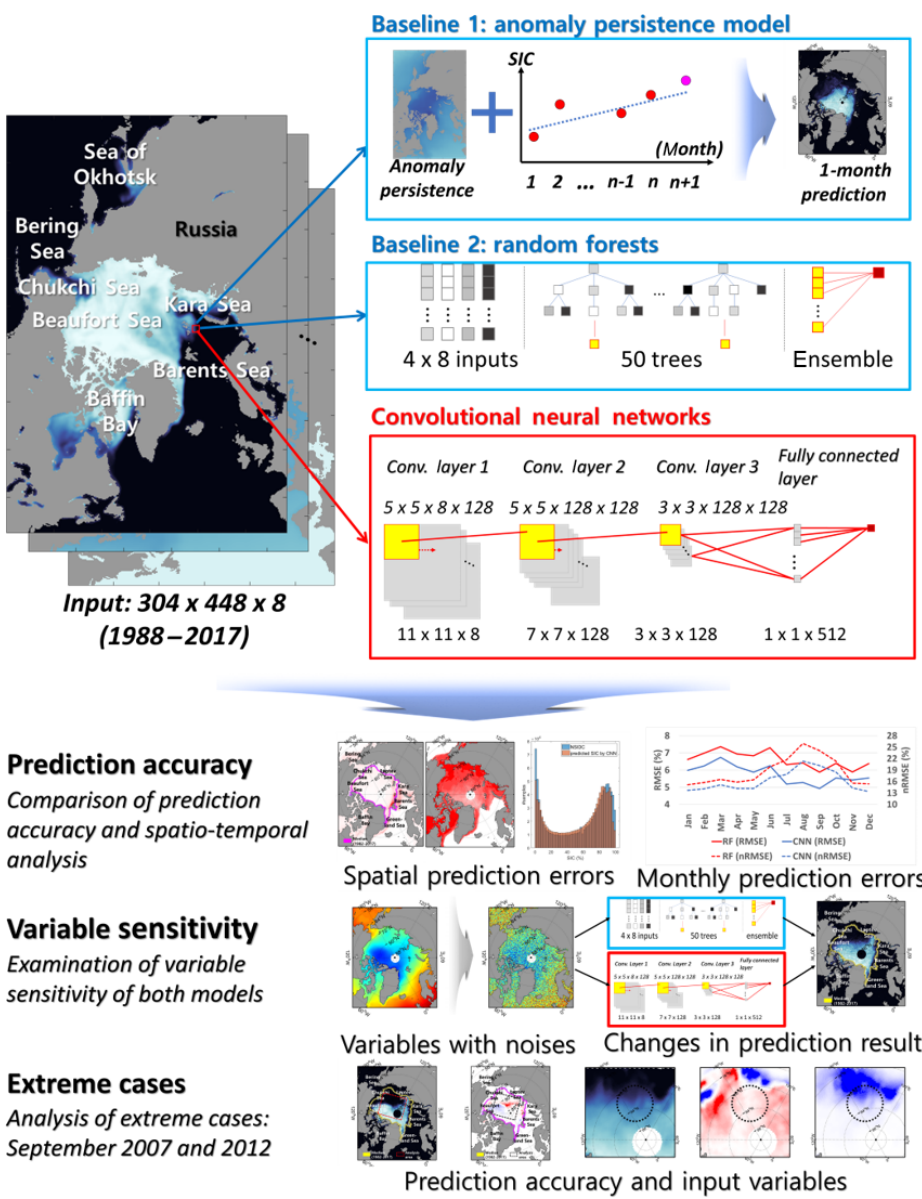
Figure 1. Study area and research